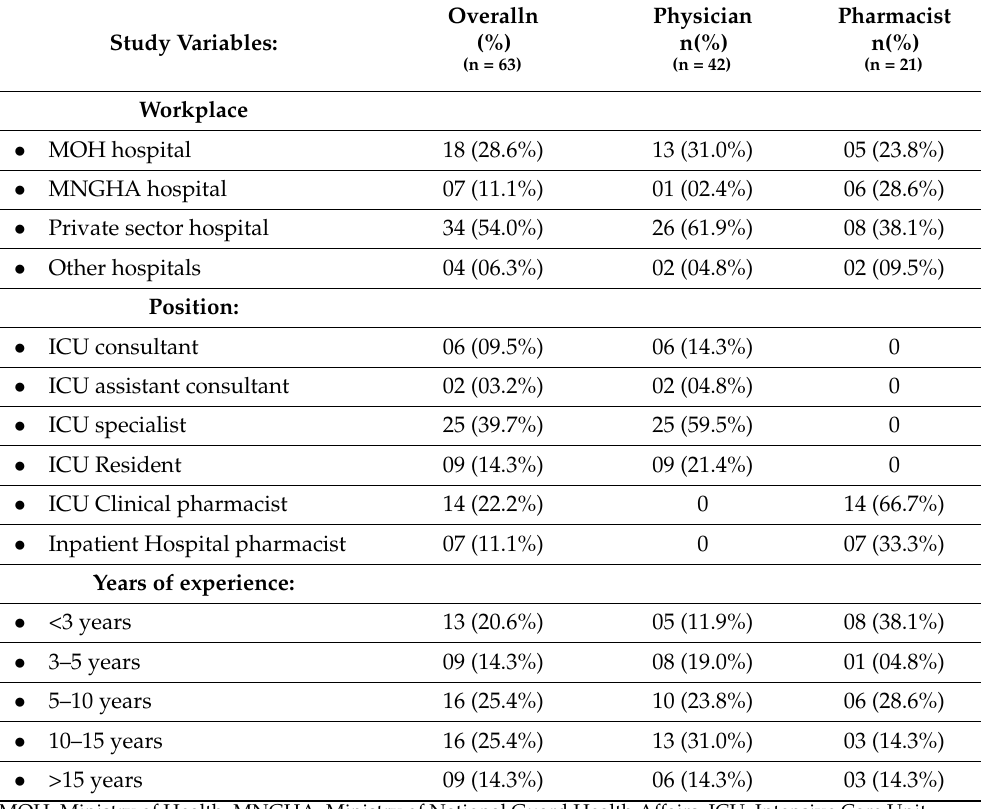
Table 1. Socio-demographic characteristics of participants according to physician and